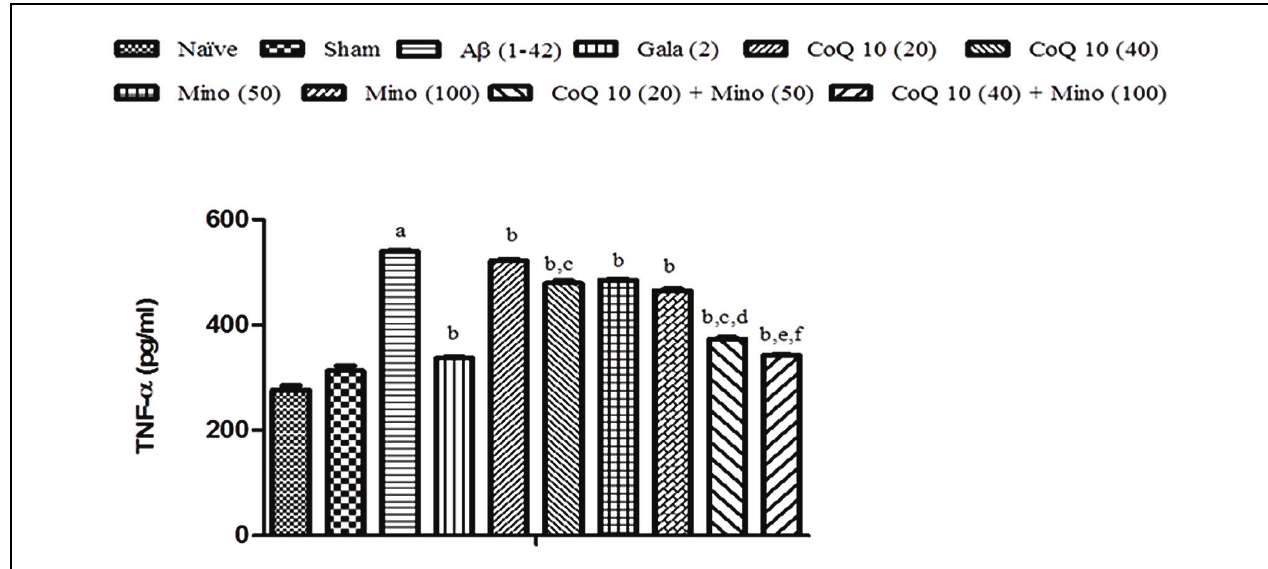
FIGURE 6 | Effect of CoQ10 and minocycline alone and in combination on TNF- α level in A β (1-42) treated rats. Data expressed as mean ± SEM, a P < 0.05 compared to sham group, b P < 0.05 compared to A β (1-42) treated group, c P < 0.05 compared to CoQ10 (20) group, d P < 0.05 compared to Mino (50) group, e P < 0.05 compared to CoQ10 (40), f P < 0.05 compared to Mino (100) group (One way ANOVA followed by Tukey’s test). (A β , Amyloid beta; Gala, Galantamine; CoQ10, Coenzyme Q 10; Mino,